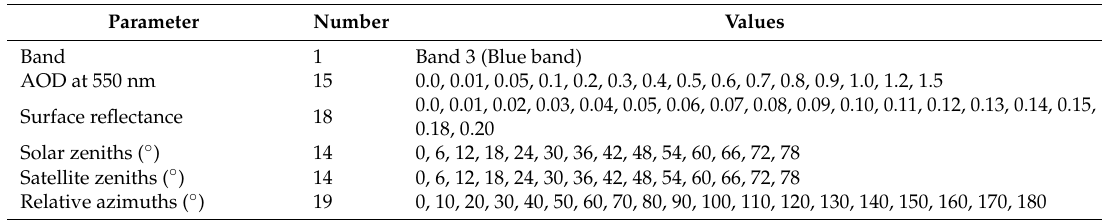
Table 4. The parameters used in the look-up table construction.